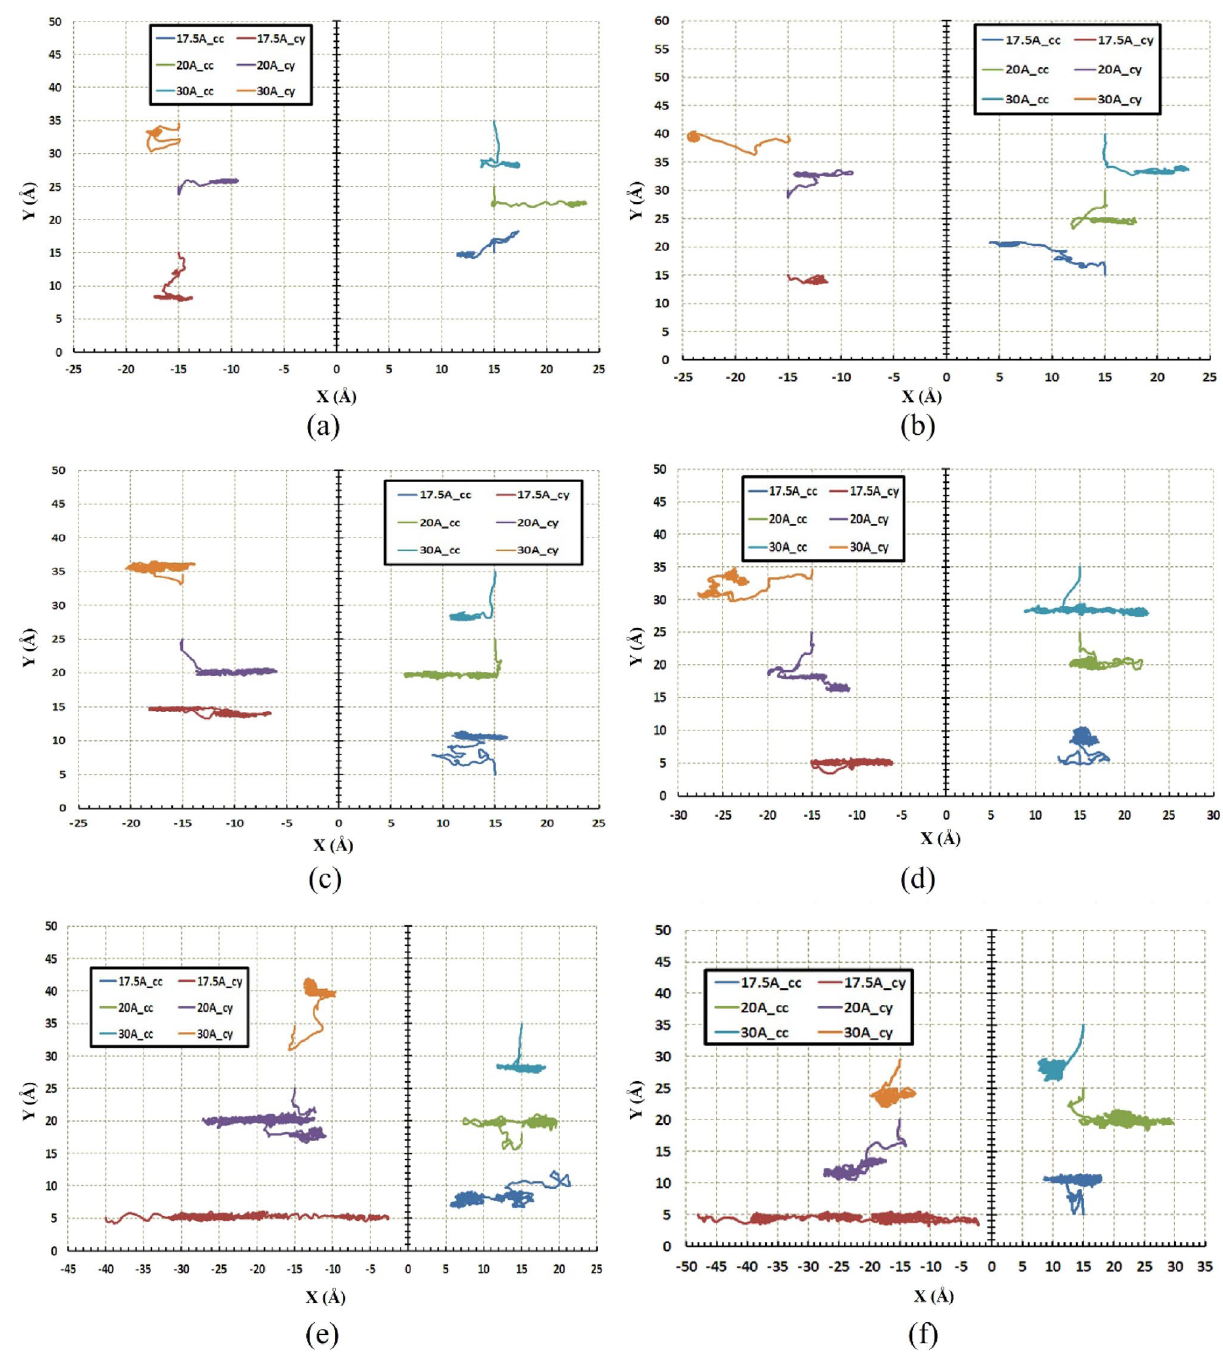
Figure 14. Trajectories of the nanotruck on the concave (cc) and the cylindrical (cy) substrates during simulations ( a ) 75 K , ( b ) 150 K , ( c ) 300 K , ( d ) 400 K , ( e ) 500 K , and ( f ) 600 K . Nanotruck has fluctuated at almost all temperatures in both geometries except the radius of 17.5 Å cylindrical substrates at 500 K and 600 K that nanotruck has long-range